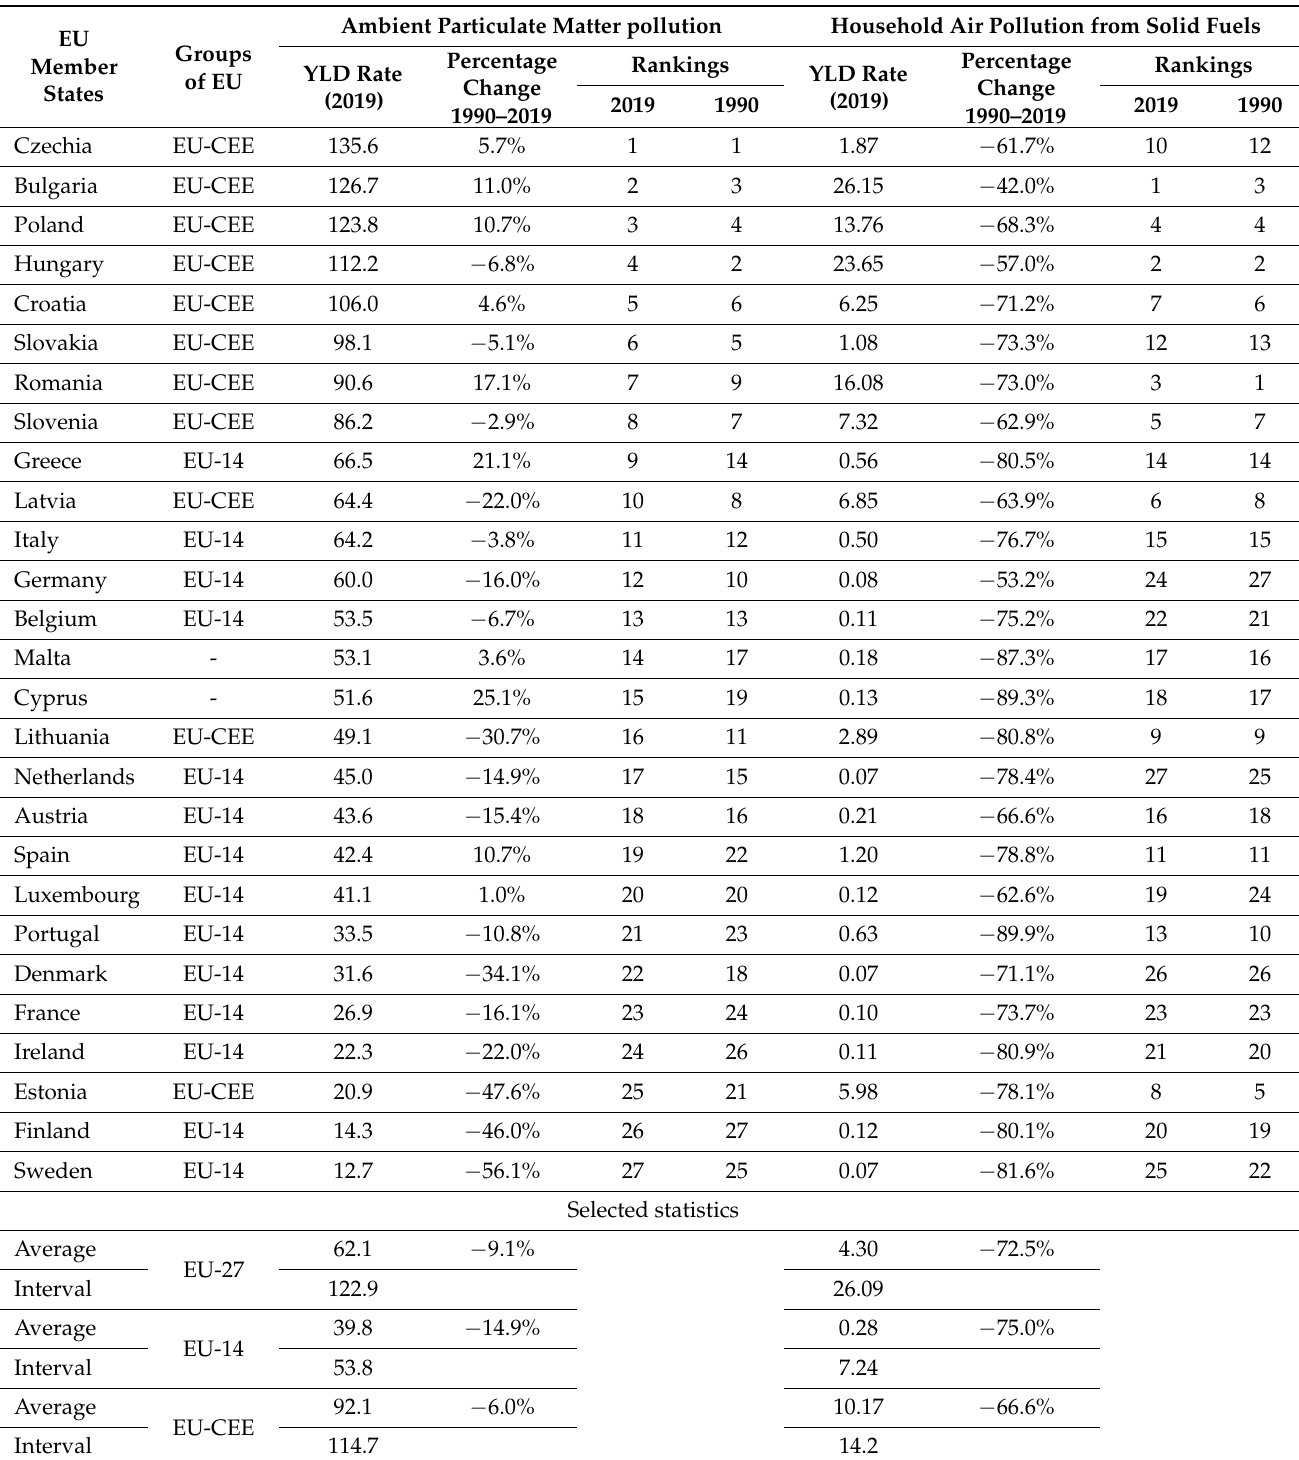
Table 2. Number of years lived with disability (YLD) due to chronic diseases as a result of